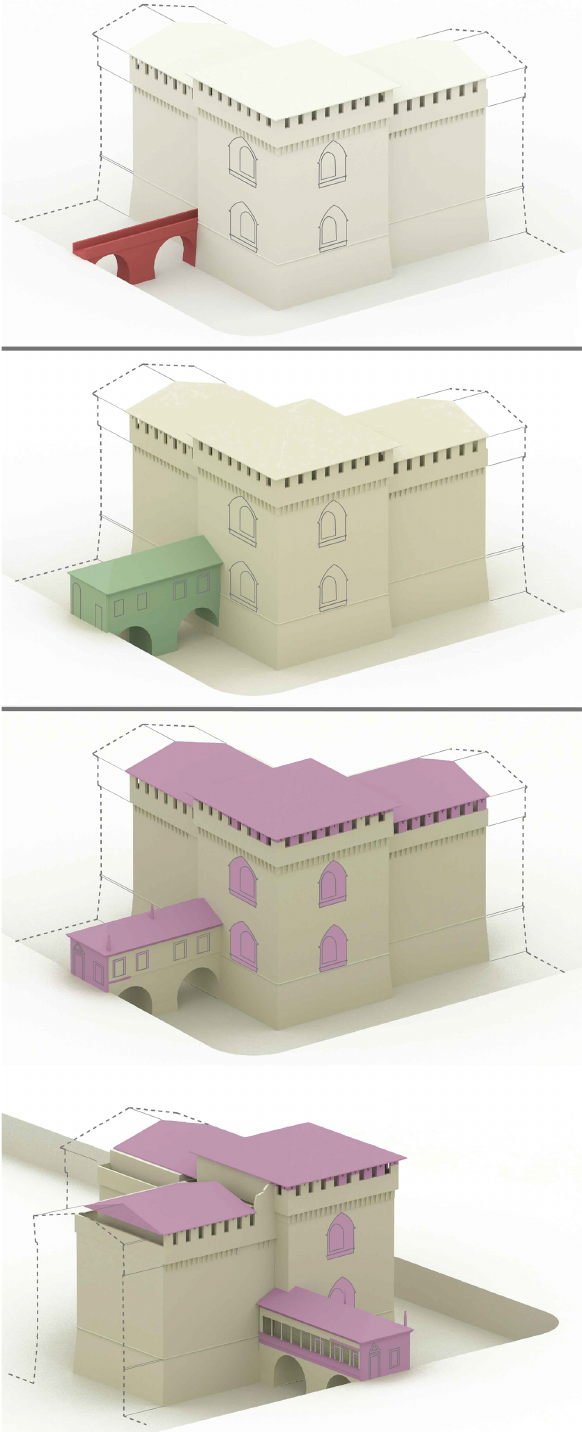
Figure 7. Three-dimensional schematic representations showing architectural structure transformations over time. From the top, model of the III phase (red), model of the IV phase (green) and model of the VI phase from both sides